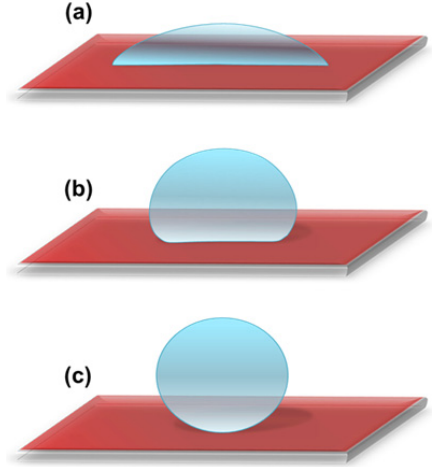
Figure 1. A schematic showing ( a ) hydrophilic surface with water contact angle less than 90°; ( b ) hydrophobic surface with water contact angle greater than 90° and ( c ) superhydrophobic surface with water contact angle larger than 150°.